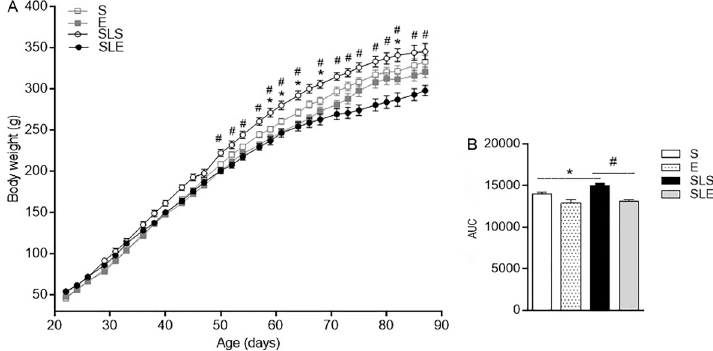
Figure 2. Body weight from sedentary (S, n=10), exercise (E, n=11), small-litter sedentary (SLS, n=14), and small-litter exercise (SLE, n=18) rats measured from 22 to 90 days of age ( A ). Body weight ( B ) evaluated by area under the curve (AUC). Data are reported as means ± SE. # P o 0.05, SLS vs SLE; *P o 0.05, S vs E and SLS (ANOVA).